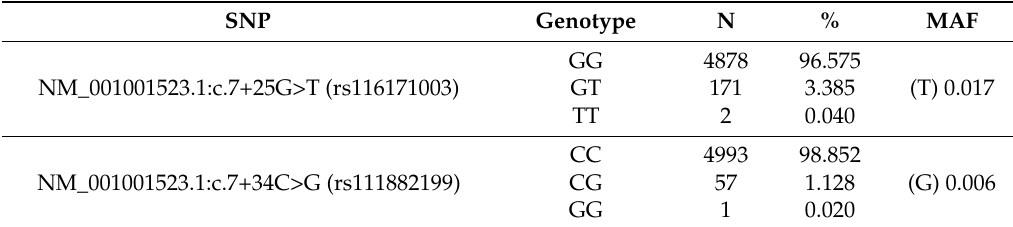
Table 1. Summary of ROR γ T promoter variants detected by HRM